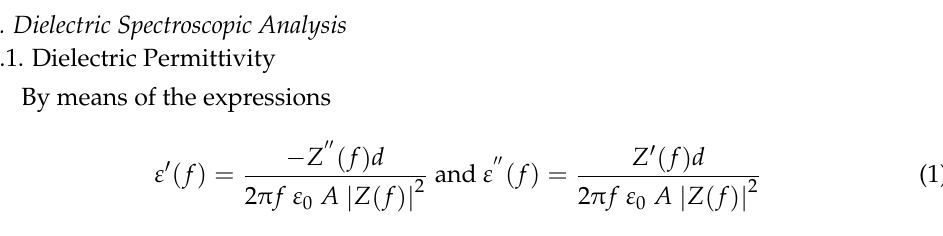
Figure 7. Comparison of the temperature dependencies of ion conductivity ( σ ) determined for PEO/E8 ( a ) and PEO/E8/NaIO 4 ( b ). The dashed lines point out the values of glass transition temperatures ( T g ) and melting temperatures ( T m ) for both composites. The error bars represent the uncertainty limits, discussed in Section 2.